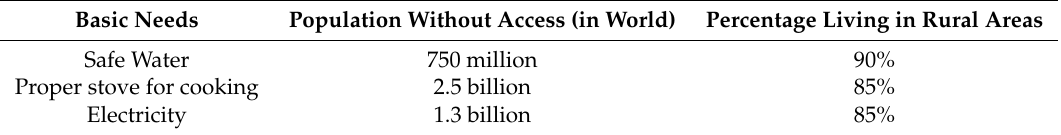
Table 1. Percentage of Energy Deprived Rural Areas